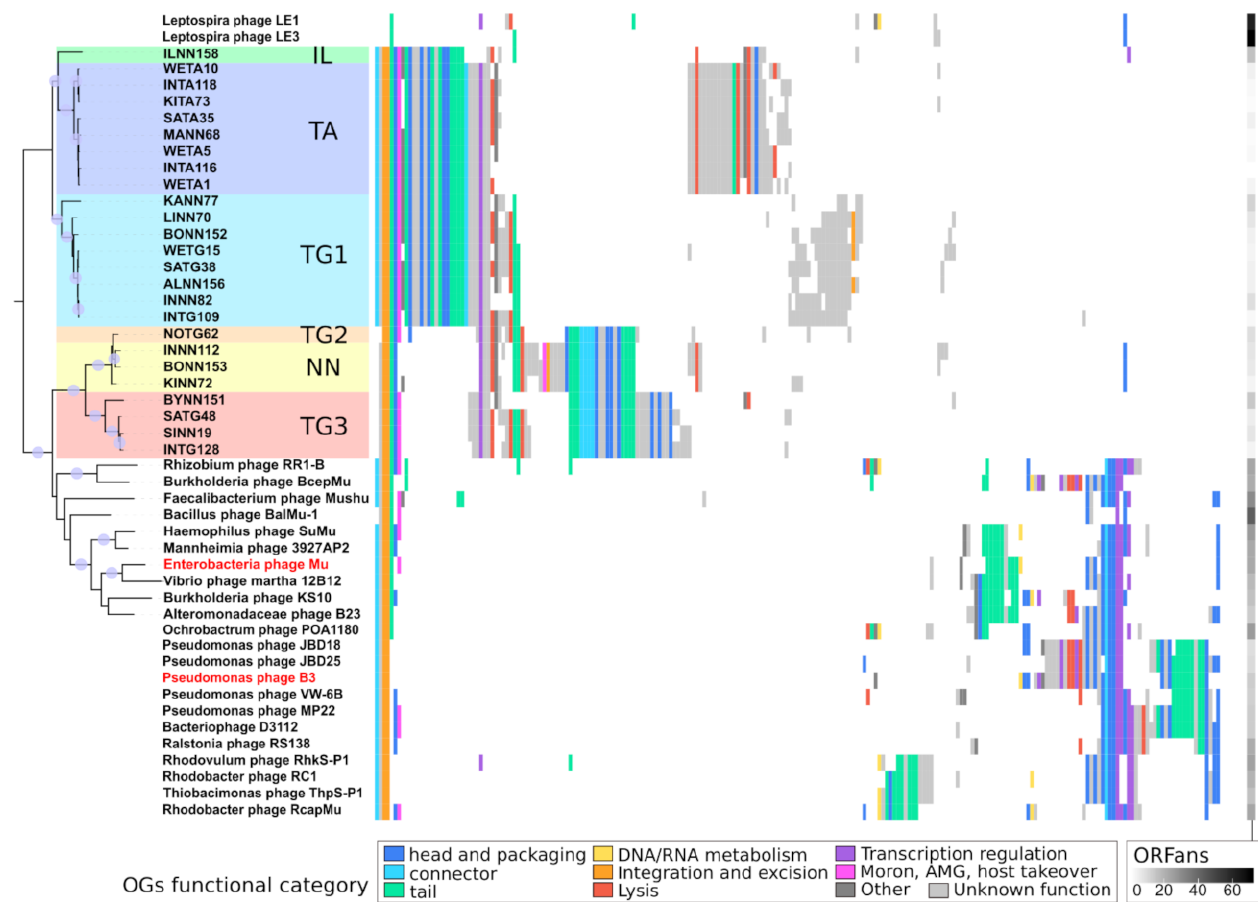
Figure 3. Distribution of orthologous groups (OG) of proteins among reference transposable phages, leptospiral phages and predicted Leptospiraceae prophages. One representative genome was chosen for each (pro)phage genus defined by VIRIDIC. Viruses are organized according to the baseplate subunit protein BW2 phylogeny. Each OG is represented by a column and is colored according to its functional category defined in the PHROG database. The first eight columns of the gene content heatmap represent Ogs conserved in most prophages and known transposable phages and are, from left to right: OG11 (tail completion or neck protein Ne1), OG6 (GemA), OG3 (TnpA), OG2 (TnpB), OG7 (BW2), OG4 (Terminase small subunit), OG5 (Gam), and OG67 (DNA methyltransferase). Ogs containing only one or two proteins were here considered as ORFans and their number in each genome is displayed as a separate column with a grey gradient on the